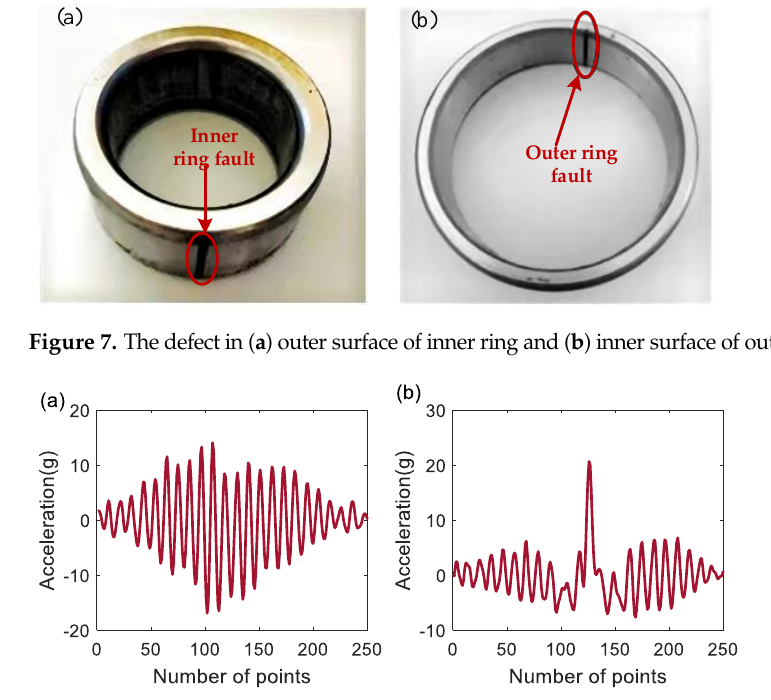
Figure 8. The FEM-based wavelet bases: ( a ) for inner and ( b ) outer raceway faults.